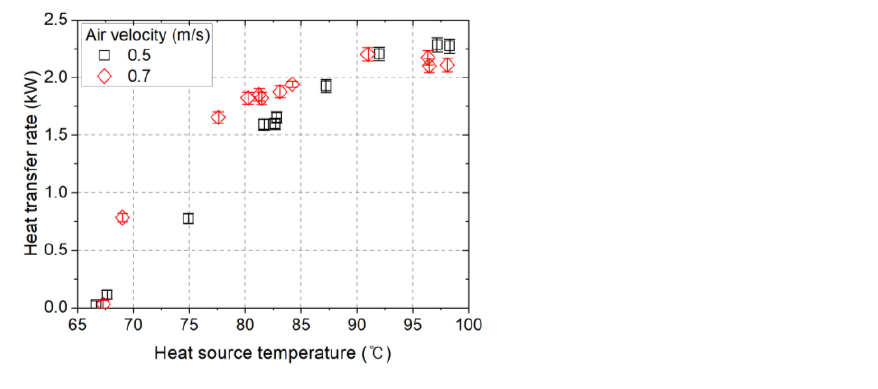
Figure 8. Average heat transfer rates in the FHP model at various water-heating temperatures. This observed behavior can be interpreted using the concept of a thermal resistance circuit for the FHP model. Equation (6) represents the thermal resistance circuit for the FHP, where the heat transfer rate is calculated by dividing the overall temperature difference by the total thermal resistance in the circuit. The first thermal resistance ( R source ) is associated with the convective heat transfer in the concentric heat exchanger, and the second resistance ( R hp ) corresponds to the effective thermal resistance of the heat pipe. The final resistance term ( R sink ) is related to the air-side convection heat transfer. An increase in the air-cooling velocity directly improves the heat transfer efficiency in the heat sink ( h sink ); hence, it reduces the total thermal resistance and improves heat transfer through the FHP: